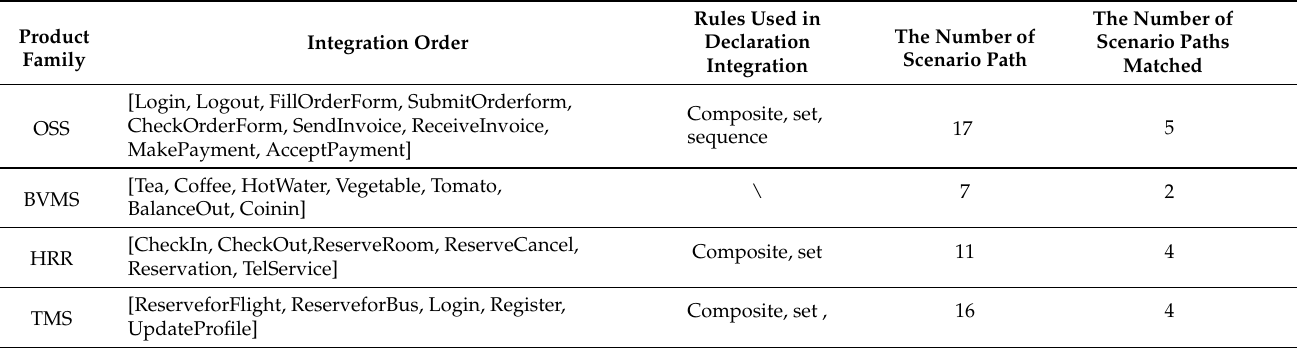
Table 3. The implementation details of four product family models’ derivation.